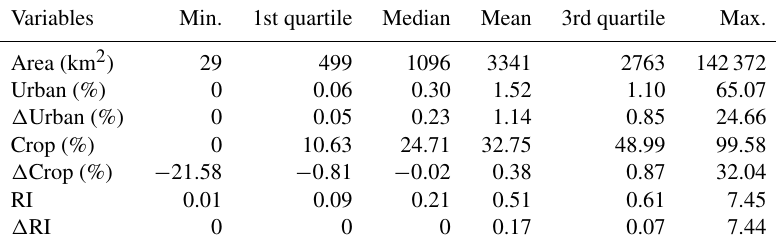
Table 1. Summary of catchment characteristics for 757 independent catchments. For each catchment, among its all years with available flood data in 1992–2017, we choose the last year to calculate Urban, Crop, and RI and choose the first and last years to calculate (cid:49) Urban, (cid:49) Crop, and (cid:49) RI. The summaries of RI and (cid:49) RI are calculated based on 207 catchments with at least one large and medium dam.